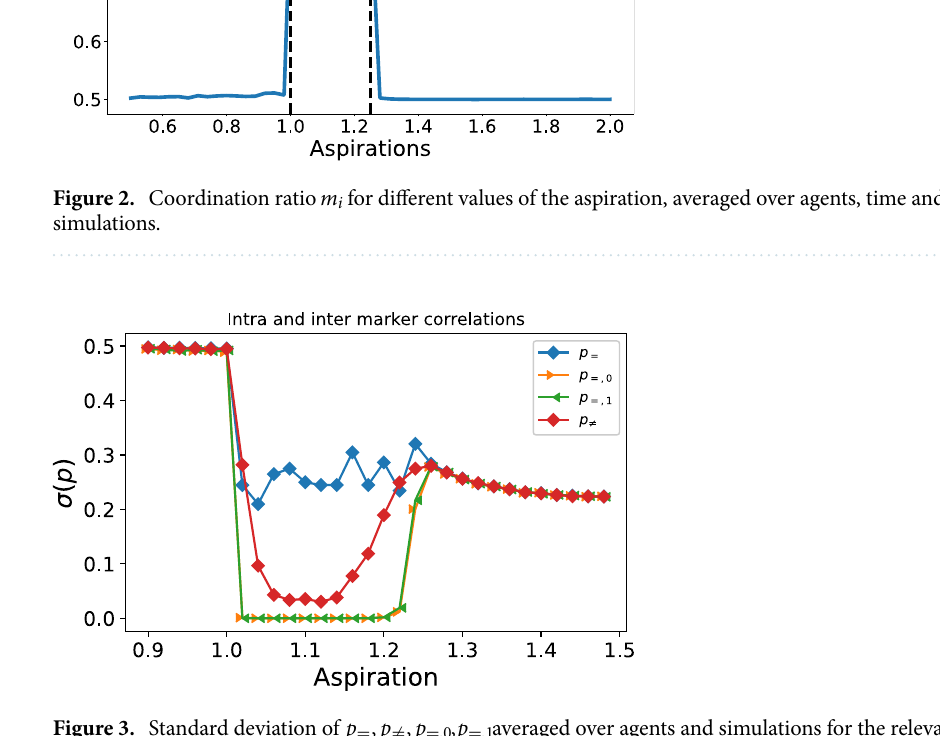
Figure 3. Standard deviation of p = , p �= , p = ,0 , p = ,1 averaged over agents and simulations for the relevant range of aspirations. The parameters used are the same of Fig.